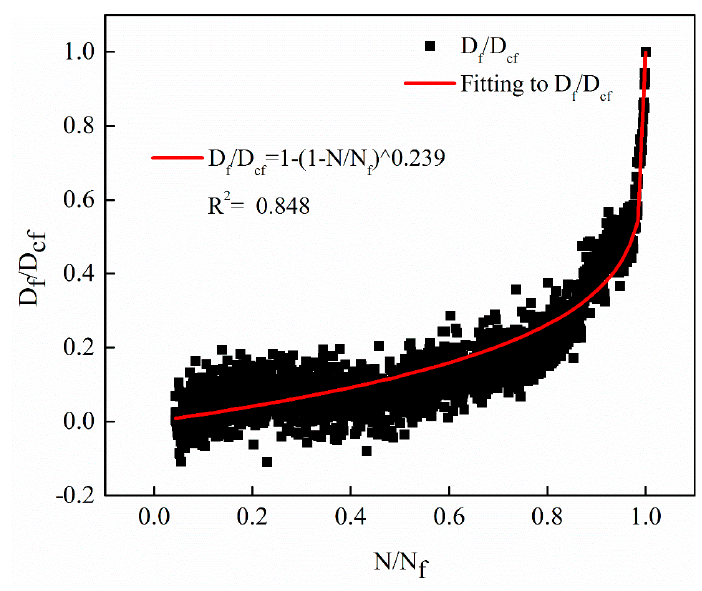
Figure 15. The evolution curves with stress levels of 0.5 MPa.